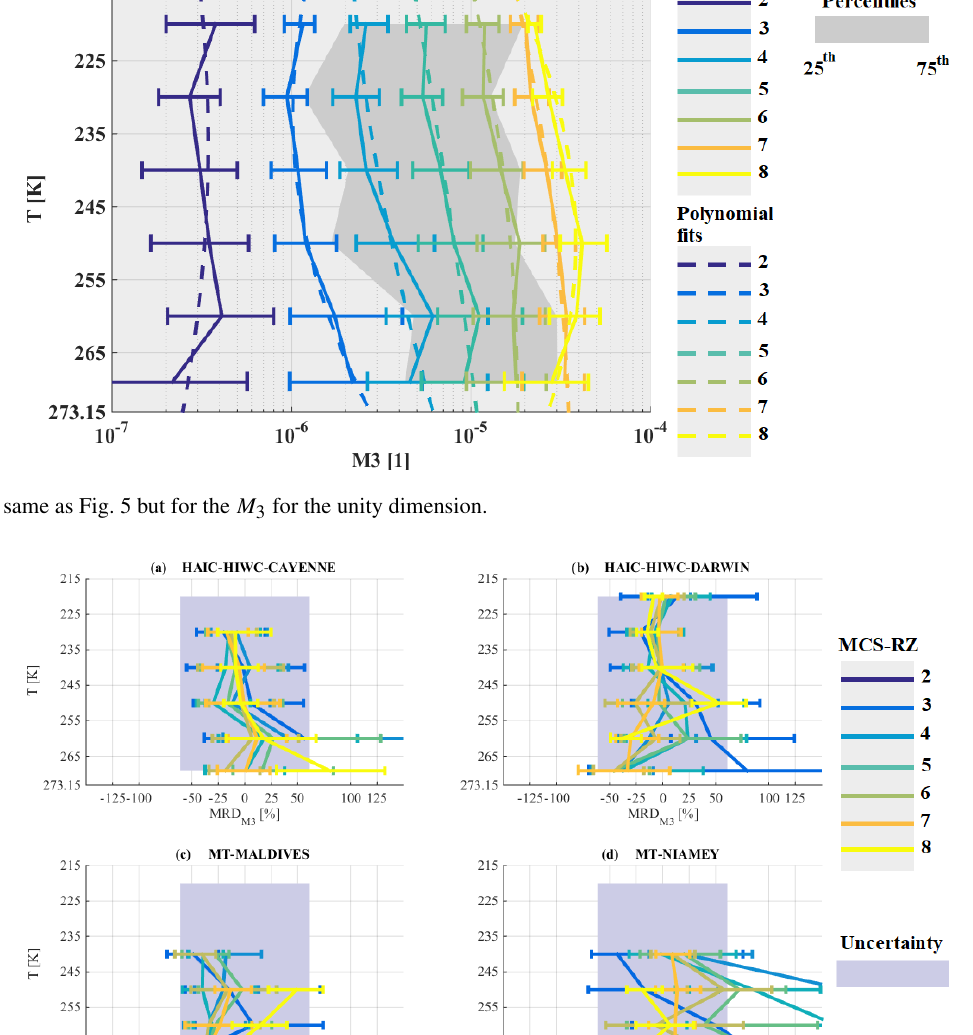
Figure 27 provides median relative errors (whiskers represent the 25th and 75th percentiles) of parameterized moments M 2 (Fig. 27a and b) and M 3 (Fig. 27c and d) compared to re- spective moments calculated directly (Eq. 9) from PSD